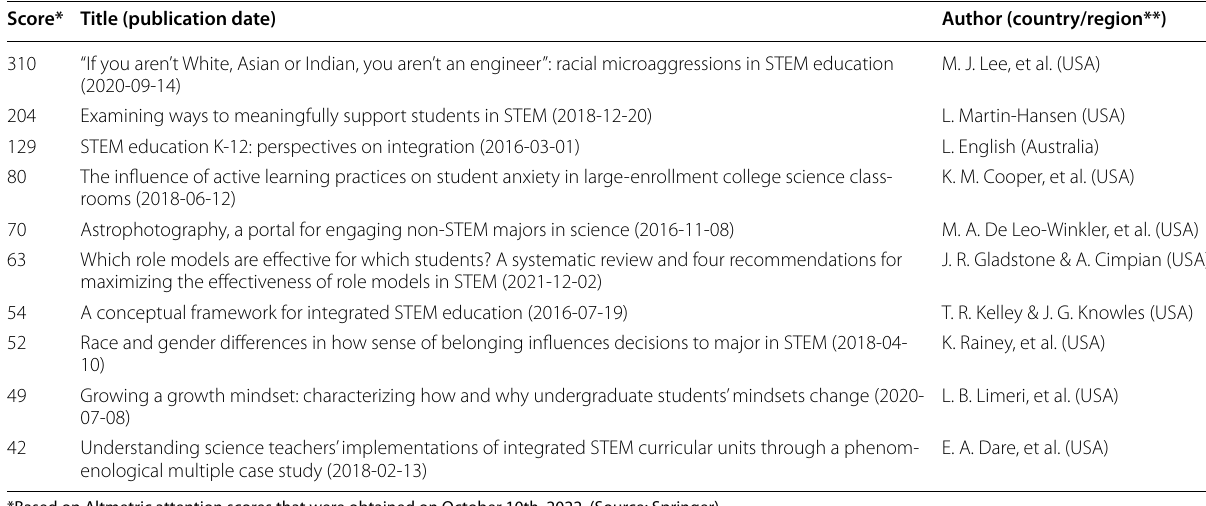
*Based on Altmetric attention scores that were obtained on October 10th, 2022. (Source: Springer) **Country/region refers to where the corresponding author’s research organization or institution was located at the time of